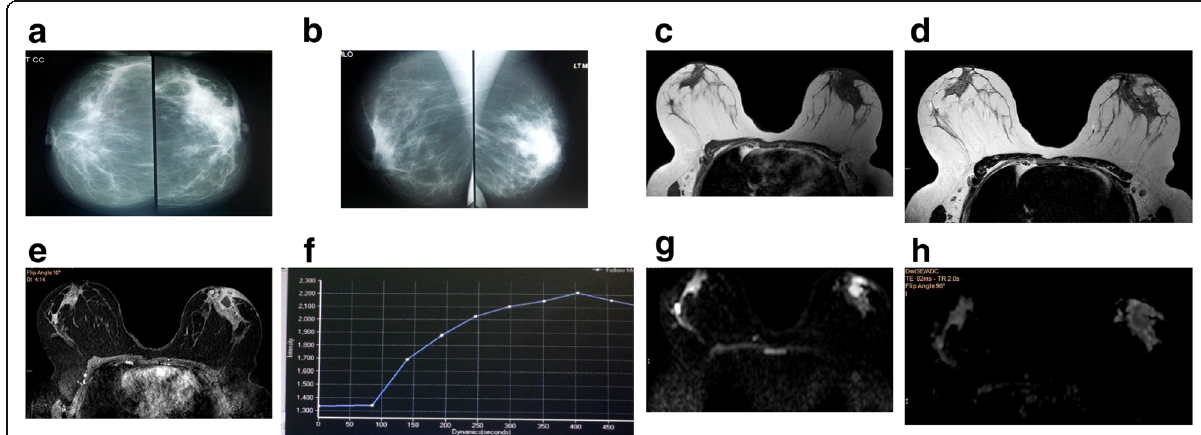
Fig. 5 A 46-year-old female patient with painless left breast lump from 1 month. History of cessation of lactation from 1 year. No response to antibiotic therapy. Mammography craniocaudal ( a ) and mediolateral oblique ( b ) views show global asymmetry in the left breast (BIRADS III lesion). Axial T1WI ( c ) and T2WI ( d ) images are showing an ill-defined area of architectural distortion with an ill-defined irregular area of liquefaction seen in the left retroareolar region. This is associated with thickened overlying skin and dilated retroareolar ducts with high intraductal signal denoting proteinaceous contents. Axial TI contrast-enhanced fat-suppressed image on dynamic sequence ( e ) shows rim enhancement with intense enhancement of the surrounding parenchyma and the overlying skin. Dynamic time-intensity curve ( f ) shows type III “ washout ” curve. The lesion shows hyperintense signal in DWI at b value = 800( g ) denoting restricted diffusion, and low signal on ADC map ( h ) with measured ADC value 0.75 × 10 – 3 mm 2 /s. MRI findings: BIRADS IV lesion. Histopathological diagnosis: chronic breast abscess with surrounding